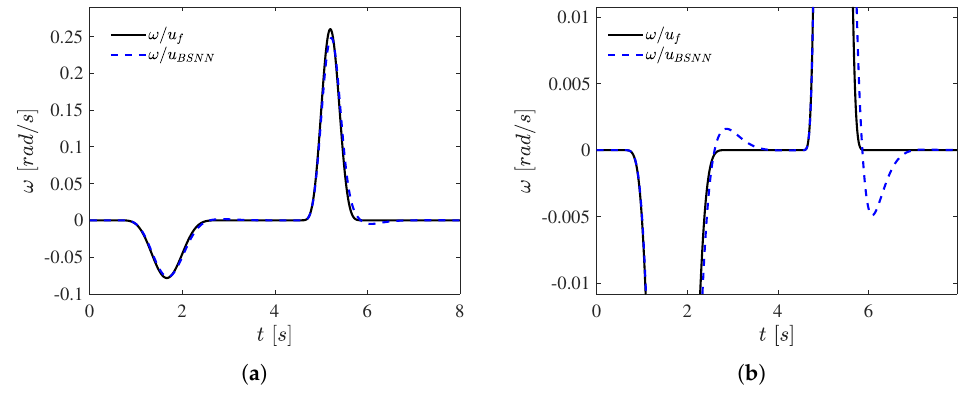
Figure 6. Speed deviation: ( a ) ω ; ( b ) zoom of ω in the main changes.